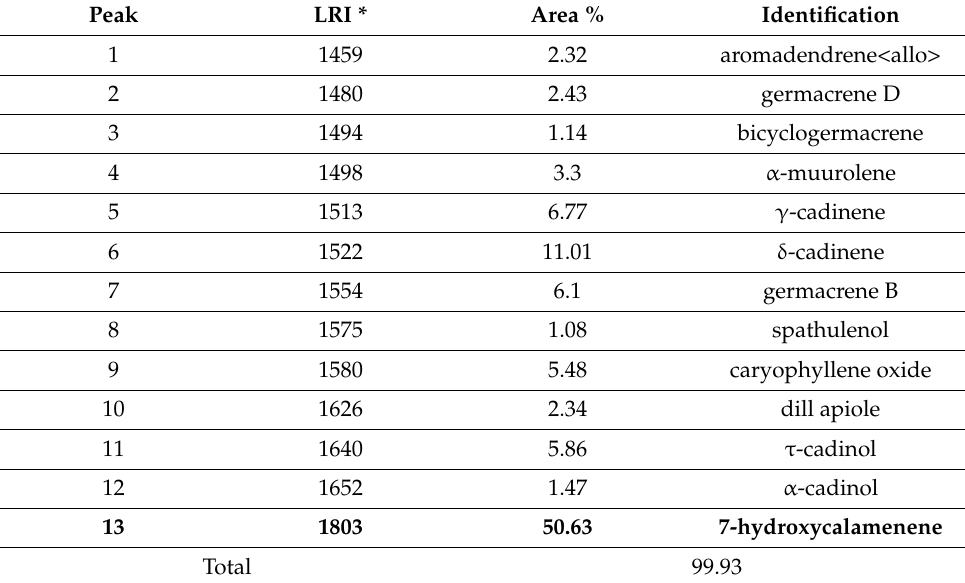
Table 1. Composition of C. cajucara essential oil used in the nanoemulsion formulation.